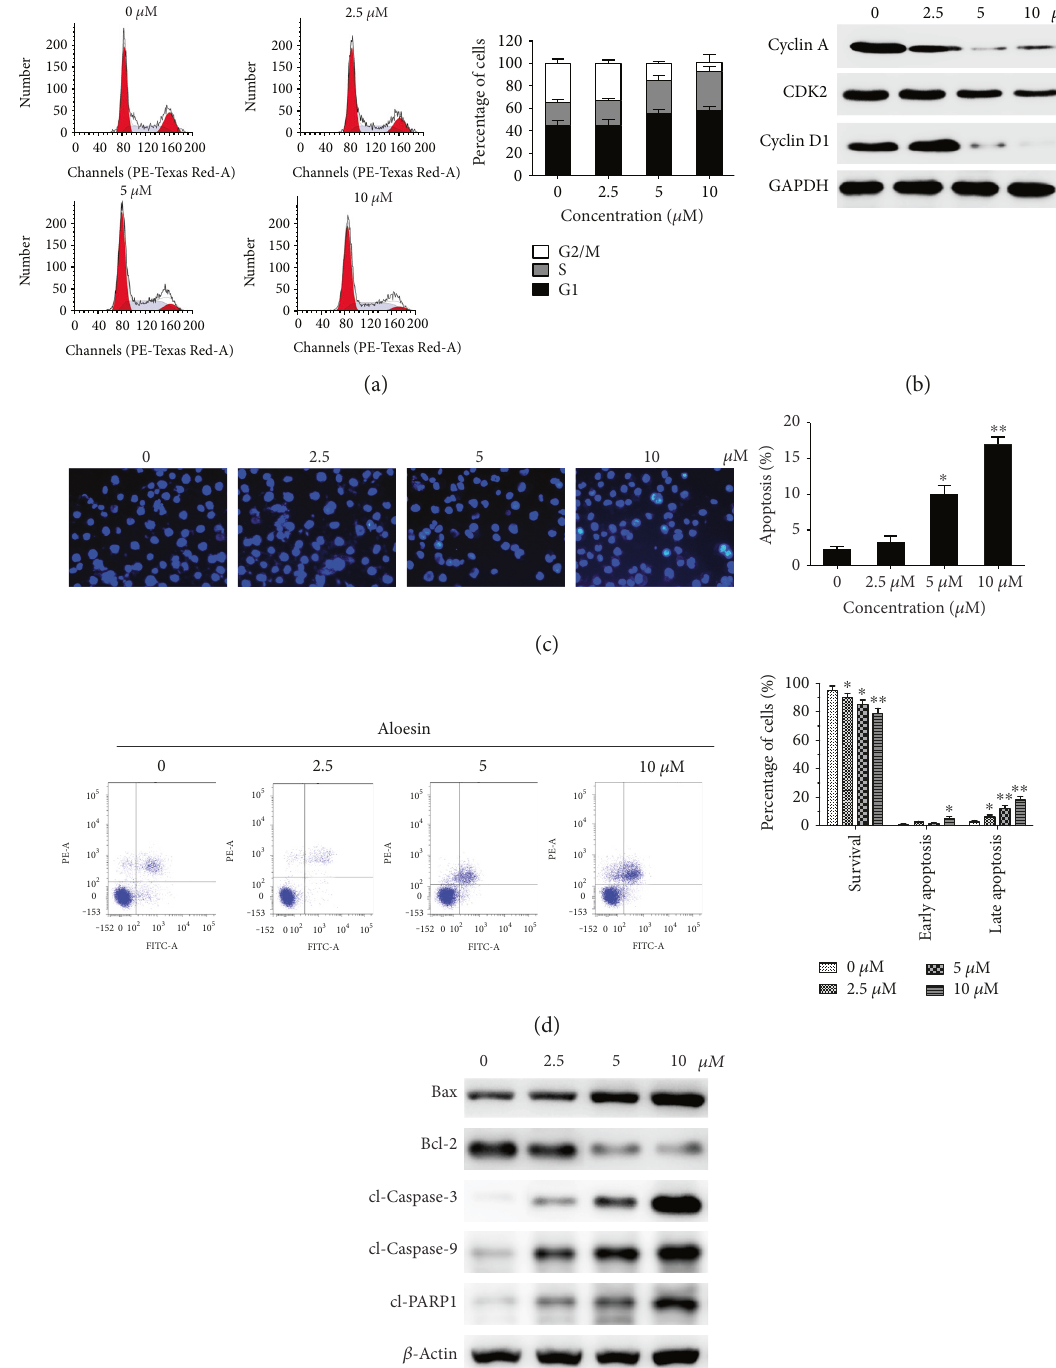
Figure 2: Aloesin arrests cell cycle and promotes cell apoptosis in SKOV3 cells. (a) SKOV3 cells without or with di ff erent doses of aloesin treatments were subject to cell cycle analysis by fl ow cytometry. Horizontal ordinate: channels (PE-A). Ordinate: cell number. (b) Western blot analysis of cell cycle-related proteins in both cell lines. β -actin was used as a loading control. Data represent the mean ± SD of three independent experiments. (c) Changes in apoptotic nuclear morphology were observed by Hoechst 33342 staining and visualized by fl uorescent microscopy. (d) Cells were analyzed by fl ow cytometry with Annexin V-FITC/PI staining after aloesin treatment. Annexin V versus PI plots from the gated cells showed the populations corresponding to viable (Annexin V − /PI − ) and necrotic (Annexin V − /PI+), early (Annexin V+/PI − ), and late (Annexin V+/PI+) apoptotic cells. Horizontal ordinate: Annexin V-FITC. Ordinate: PI-PE. (e) Western blot analysis of apoptosis-related proteins in both cell lines. β -actin was used as a loading control. Data represent the mean ± SD of three independent experiments. ∗ P < 0 05 , ∗∗ P < 0 01 versus